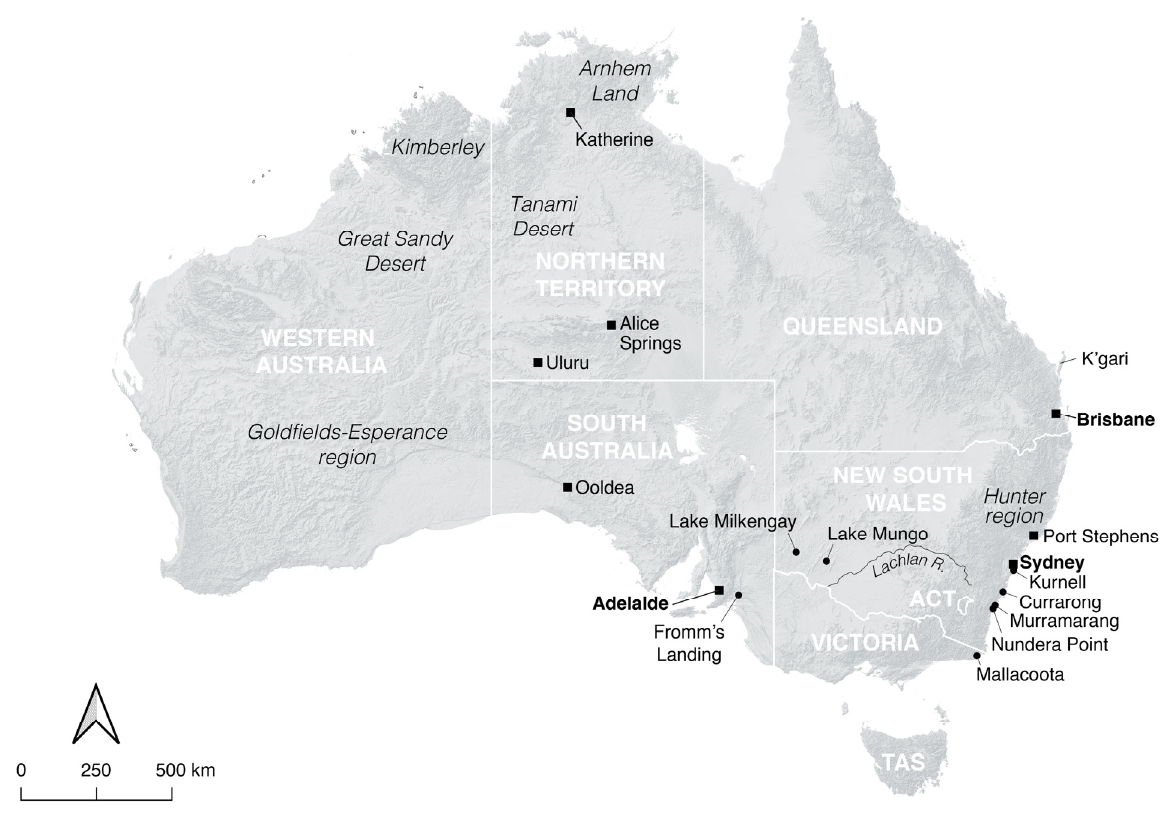
Figure 2. Map of Australia showing the places mentioned in the text. ACT = Australian Capital Territory. TAS = Tasmania. Base map prepared by Kimberlee Newman.